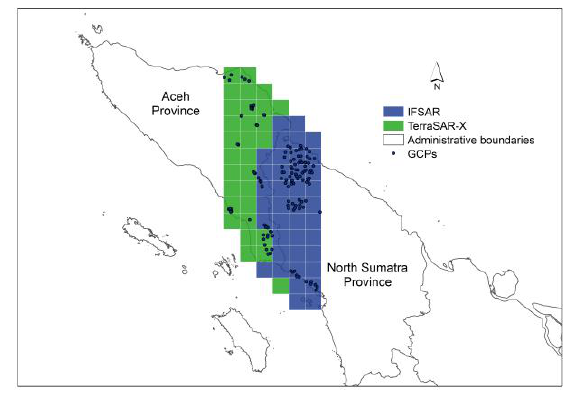
Figure 2. The area of study in the boundaries between Aceh and North Sumatra, with the distribution of GCPs.